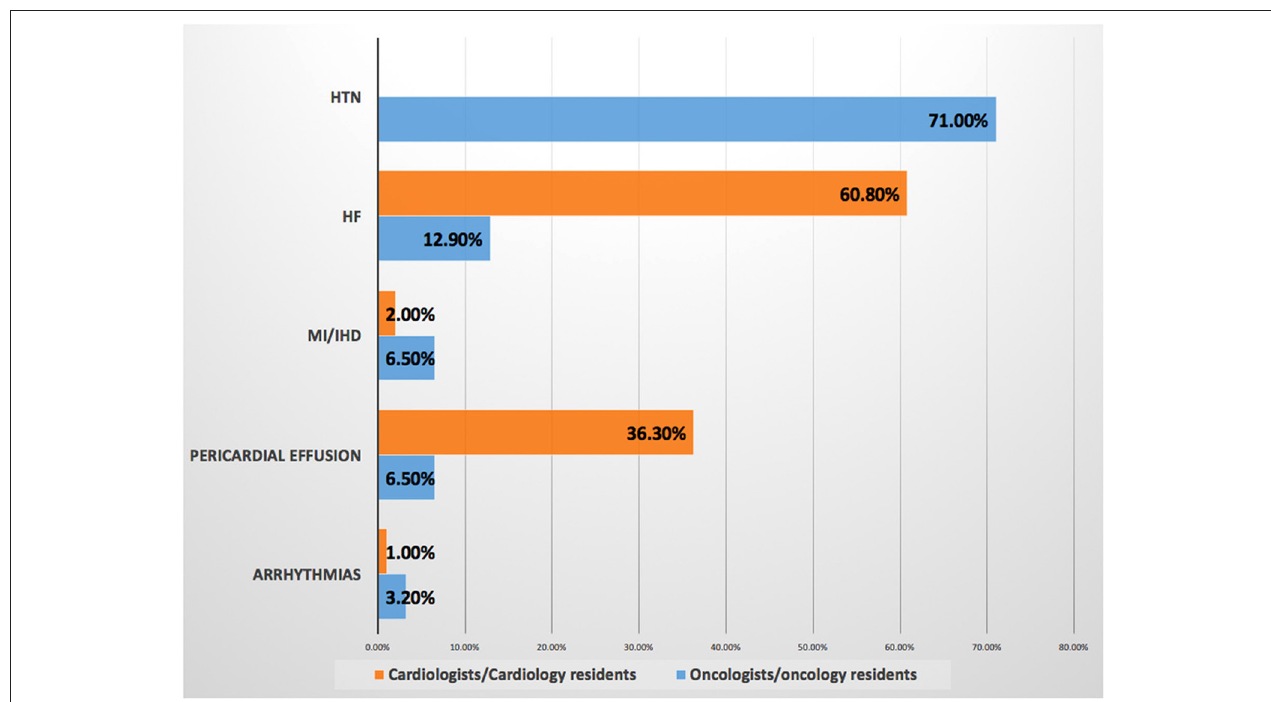
FIGURE 1 | Most common baseline cardiovascular disease among patients with cancer. Prevalence of baseline cardiovascular disease, hypertension is the most common risk factor according to responses of the oncologists/oncology residents. HF, heart failure; HTN, hypertension; IHD, ischemic heart disease; MI, myocardial infarction.